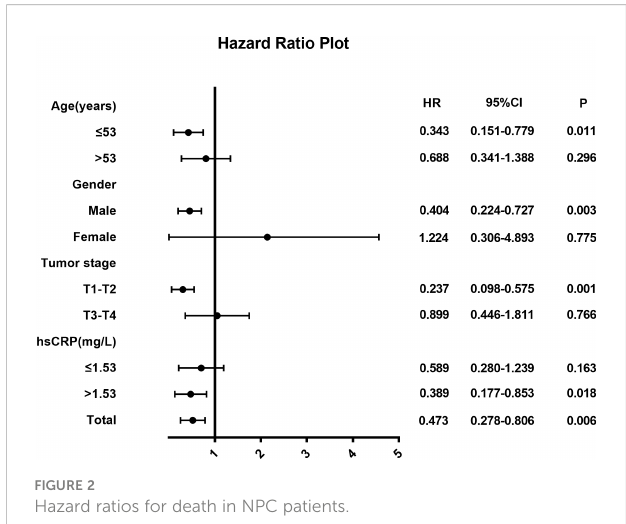
FIGURE 2 Hazard ratios for death in NPC